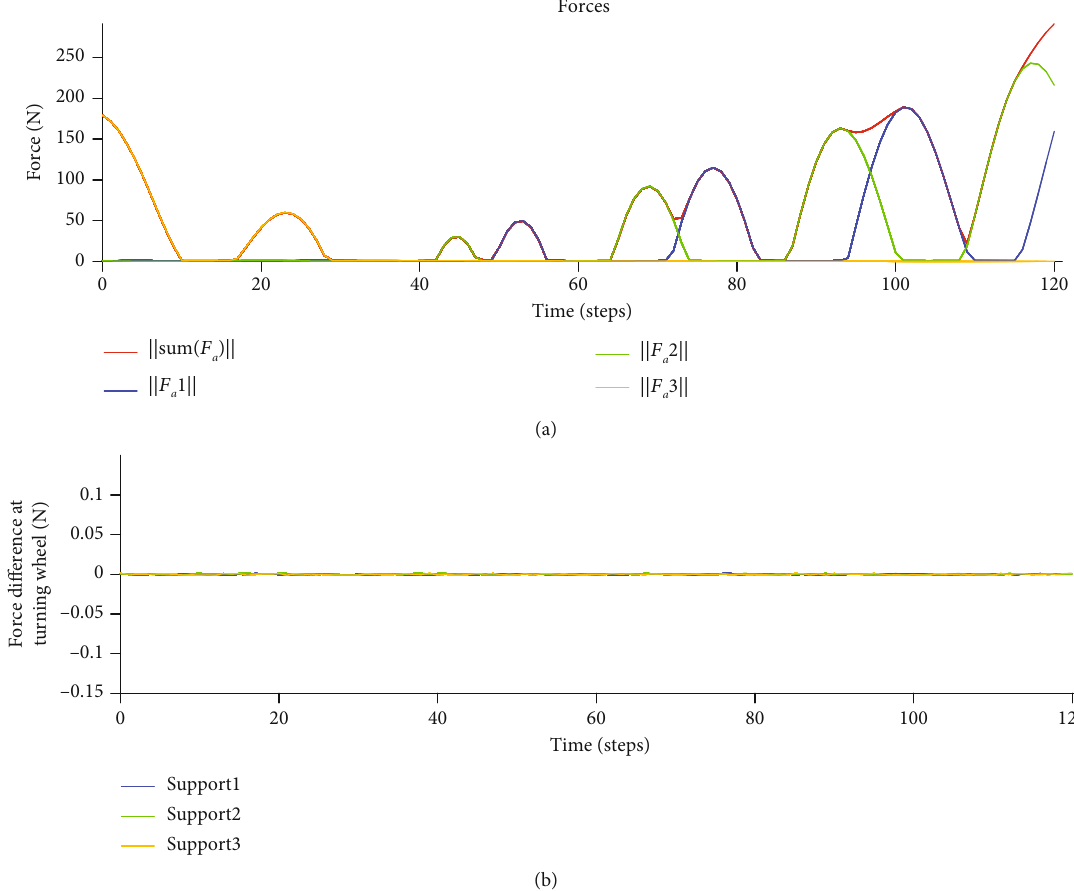
Figure 13: Forces obtained for the trajectory 1. (a) Sum of forces at the lander (in red) and the corresponding individual forces (in blue, green, and yellow), over the time steps of the lander ’ s movement. (b) Virtual forces and their di ff erence (in blue, green, and yellow) for each